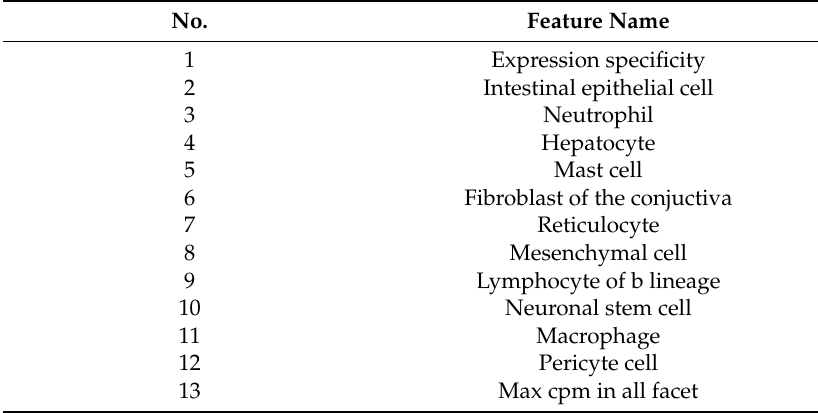
Figure 3. A box plot to illustrate the performance, measured by Matthew’s correlation coefficient, of random forest (RF) and repeated incremental pruning to produce error reduction (RIPPER) algorithms on 1000 randomly produced feature subsets. For RF, each feature subset contained the feature of expression specificity and 12 other features randomly selected from rest 70 features, while for RIPPER, each feature subset contained the feature of expression specificity and 9 other features randomly selected from rest 70 features. Table 2. Top 13 features in maximum relevance minimum redundancy (mRMR) feature list.